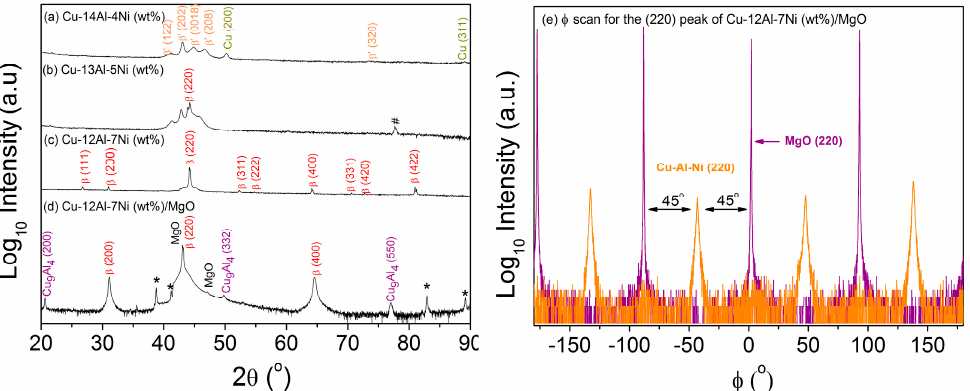
Figure 2. XRD patterns of the sputtered Cu–Al–Ni thin films: ( a ) θ / 2 θ scan for Cu–14Al–4Ni (wt.%); ( b ) θ / 2 θ scan for Cu–13Al–5Ni (wt.%); ( c ) θ / 2 θ Cu–12Al–7Ni (wt.%) films obtained by multilayer sputter deposition and subsequent heat treatment; ( d ) θ / 2 θ scan for Cu–12Al–7Ni (wt.%) film prepared on MgO substrate at 700 ◦ C; and ( e ) φ scan for the (220) peak of the β –Cu–Al–Ni film deposited at 700 ◦ C on MgO(001). # peak is unidentified. * peaks originate from the sample holder. The film grown on MgO(001) showed a Cu-12Al-7Ni (wt.%) composition. The epitaxial